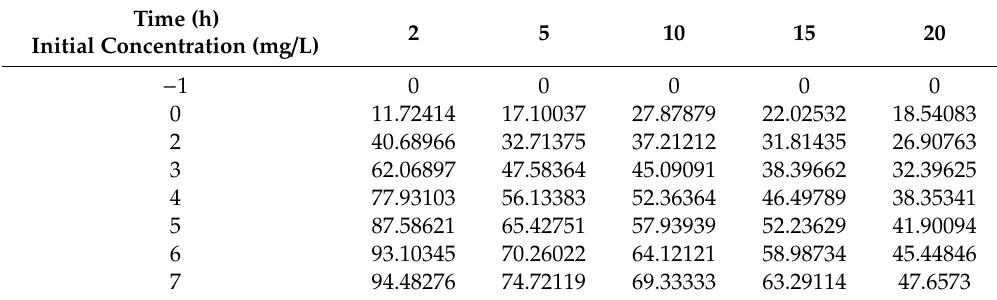
Table 1. Photocatalytic degradation rate of MB at di ff erent initial concentration.